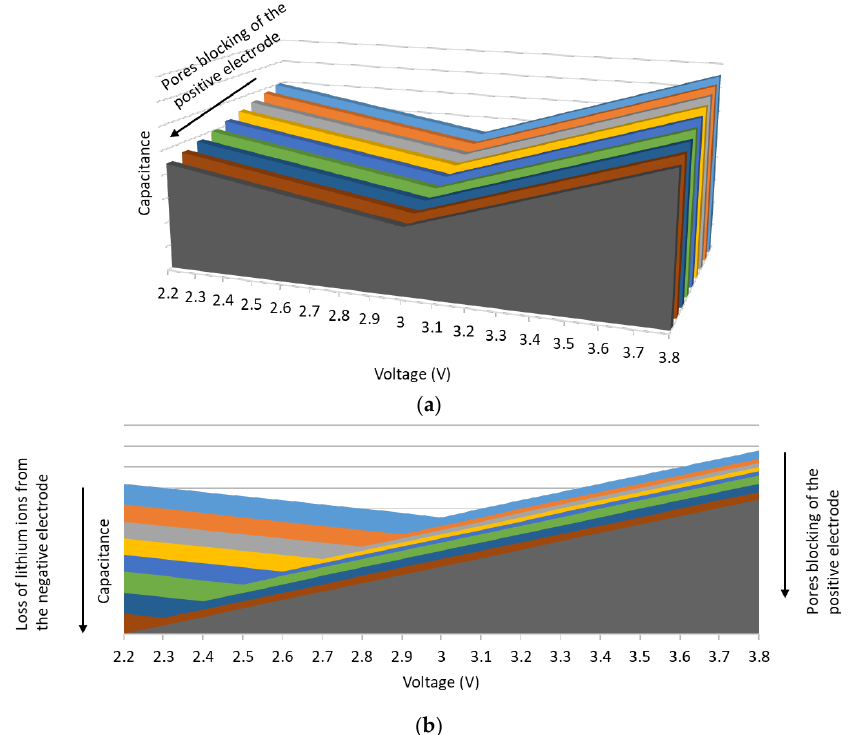
Figure 11. Effects of aging mechanisms on the C(V) curve related to: ( a ) the positive electrode, ( b ) the positive and the negative electrodes.